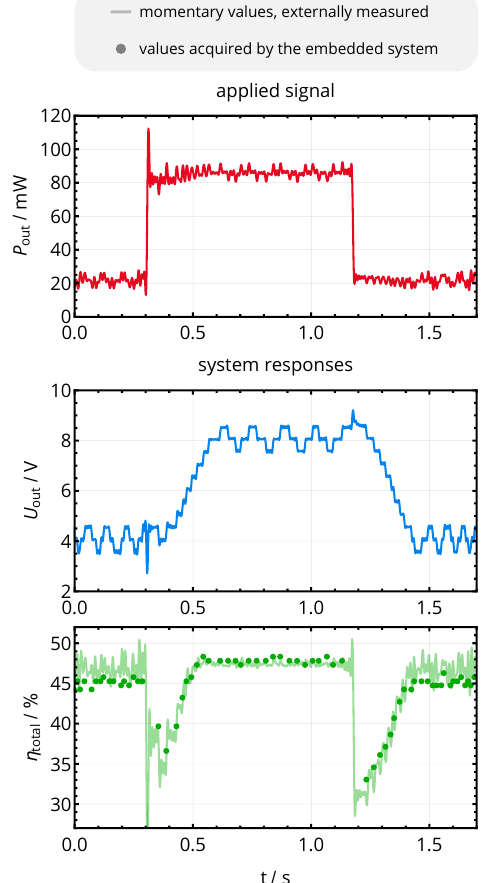
Figure 15. Reaction of the complete power feedback and maximum efficiency point tracking system with respect to a transient change in power consumption P out for a coil separation distance of d 12 = 10mm ( M 12 = 46nH). The output voltage shows the characteristic behavior of the perturb- and-observe algorithm, oscillating around the optimal voltage for a constant output power